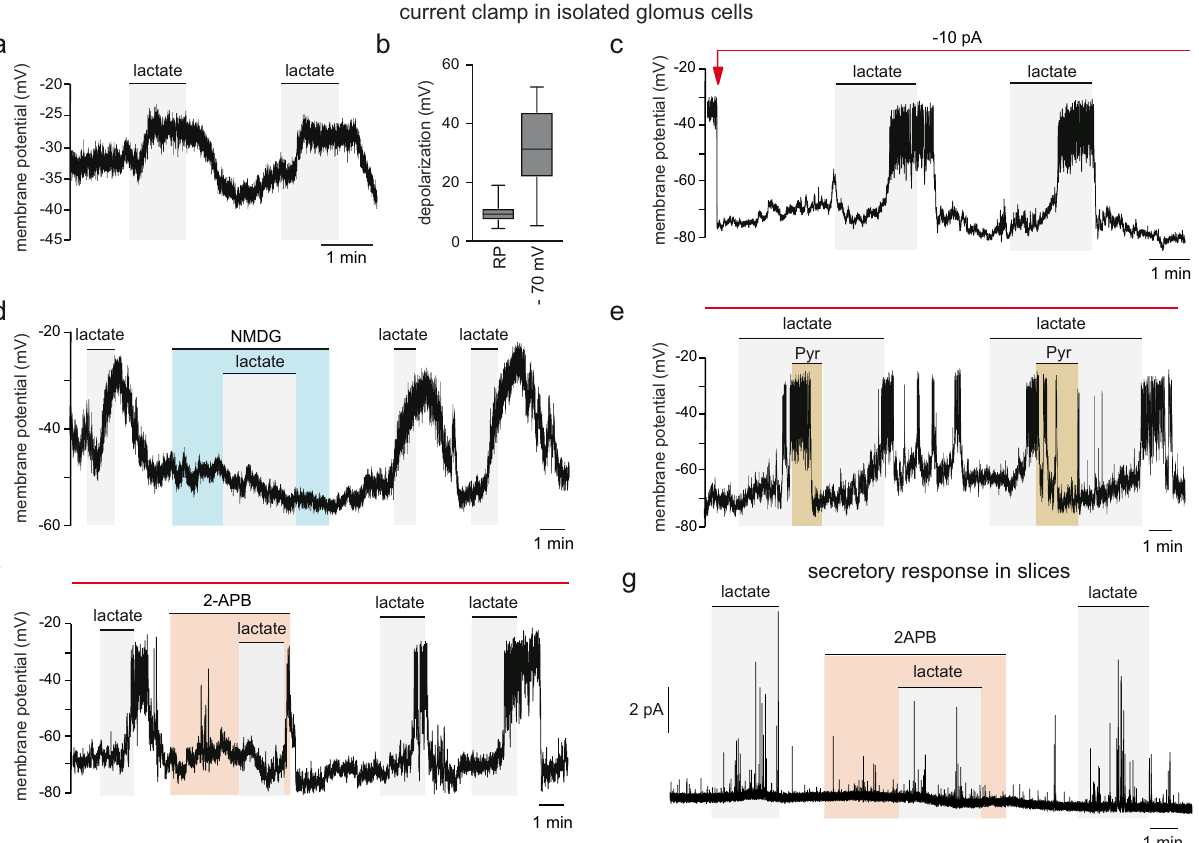
Fig. 5 Depolarization and action potential fi ring induced by lactate in glomus cells. a – c Representative examples of lactate (10 mM)-induced reversible depolarization in a current clamped cell (perforated patch) maintained at the spontaneous resting potential (RP ≈ 30-40 mV). c In cells hyperpolarized to ~ − 70 mV by current injection (red line and arrow) lactate (10 mM) induced larger depolarizations and the fi ring of action potentials. b Box